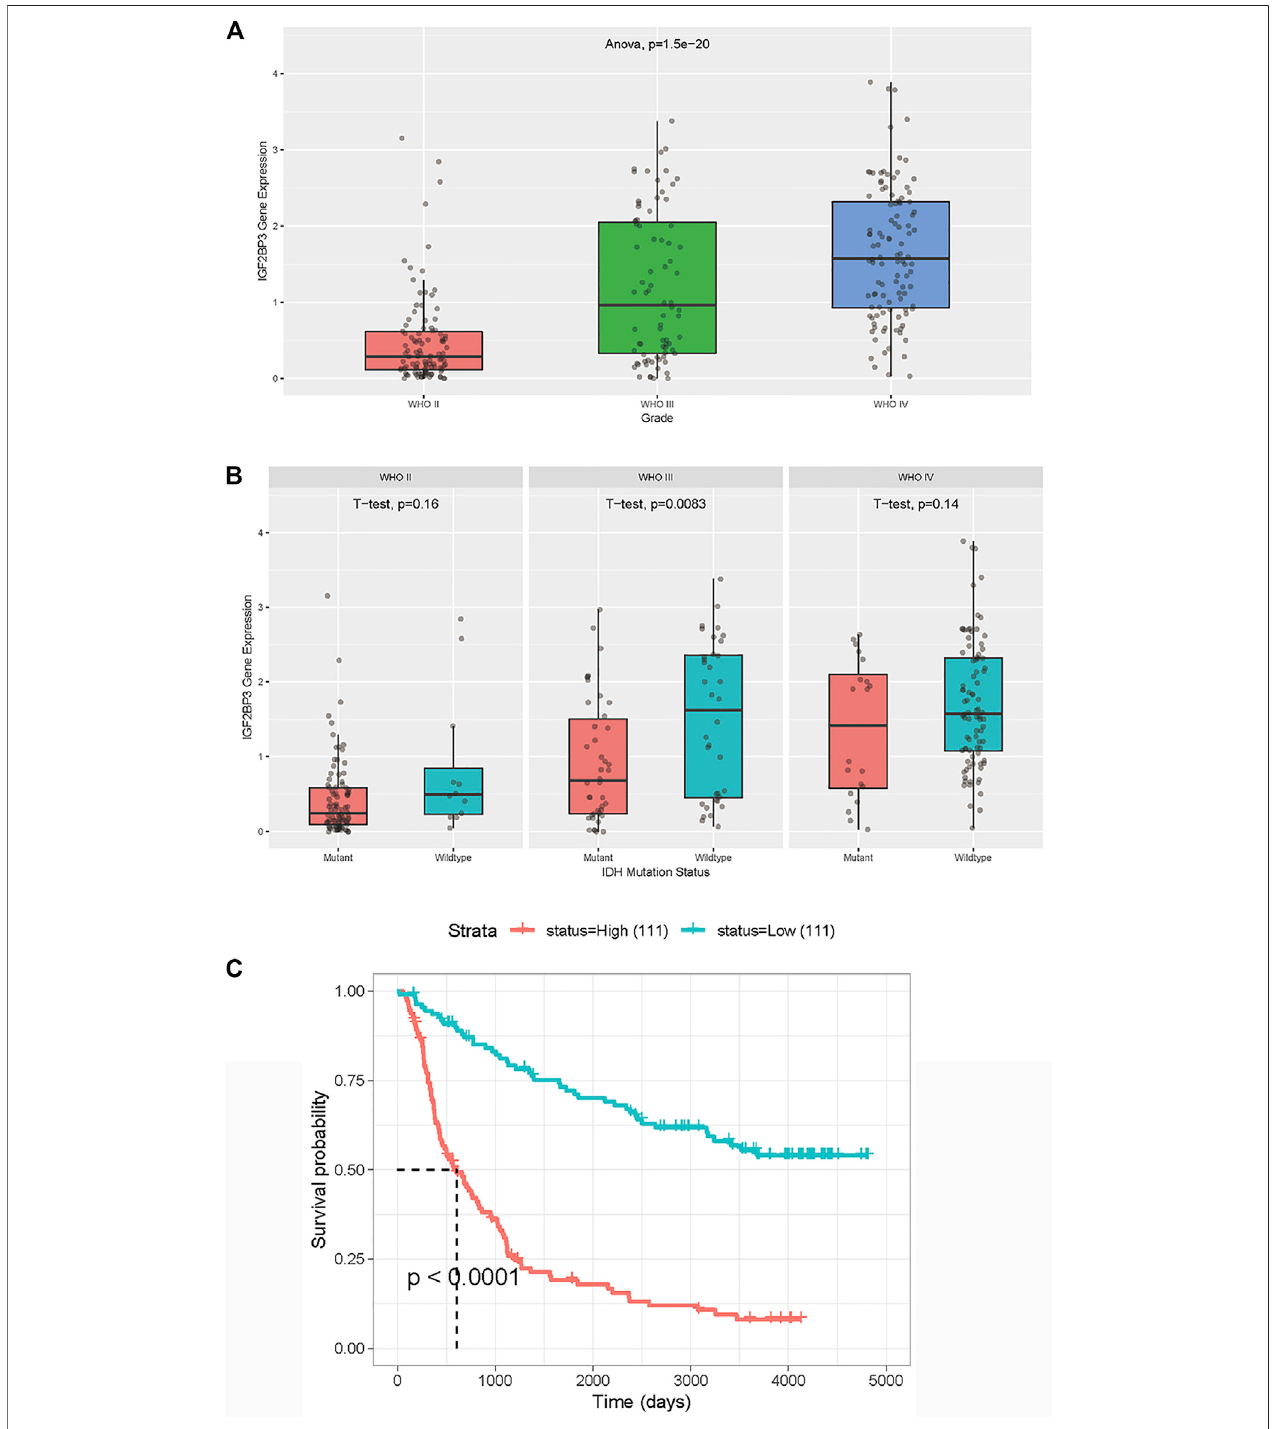
FIGURE 4 | Validation of IGF2BP3 in Chinese patients with LGG and GBM derived from the CGGA dataset. (A) Association between IGF2BP3 expression and tumor grade. The p value was generated from analysis of variance). (B) Association between IGF2BP3 and IDH. The p value was generated from the t test. (C) Overall survival was analyzed in terms of high (red) or low (blue) expression of IGF2BP3 in the CGGA dataset. The p value was generated from the log-rank test.